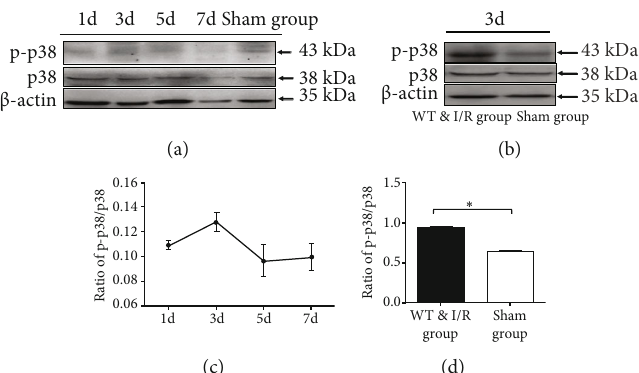
Figure 2: The expressions of p38 phosphorylation and p38 protein are time-dependent. (a) Original blots show the expression of p-p38 in the hippocampus after cerebral ischemia/reperfusion at 1d, 3d, 5d, and 7d in the WT & I/R group, compared to the sham group. (b) The bar graph shows the quanti fi cation of p-p38 MAPK phosphorylation in the hippocampus at 1 d, 3d, 5 d, and 7 d after cerebral ischemia/ reperfusion. (c, d) The expression of p-p38 in the hippocampus at 3 days after cerebral ischemia/reperfusion in WT & I/R and sham groups ( n = 4 , ∗ p < 0 : 05 , sham vs. I/R group). Data are represented as mean with SD. The comparisons were performed by Student ’ s t -test. ∗ p < 0 : 05 versus the control group. Values are mean ± SD . ∗ p < 0 : 05 by one-way